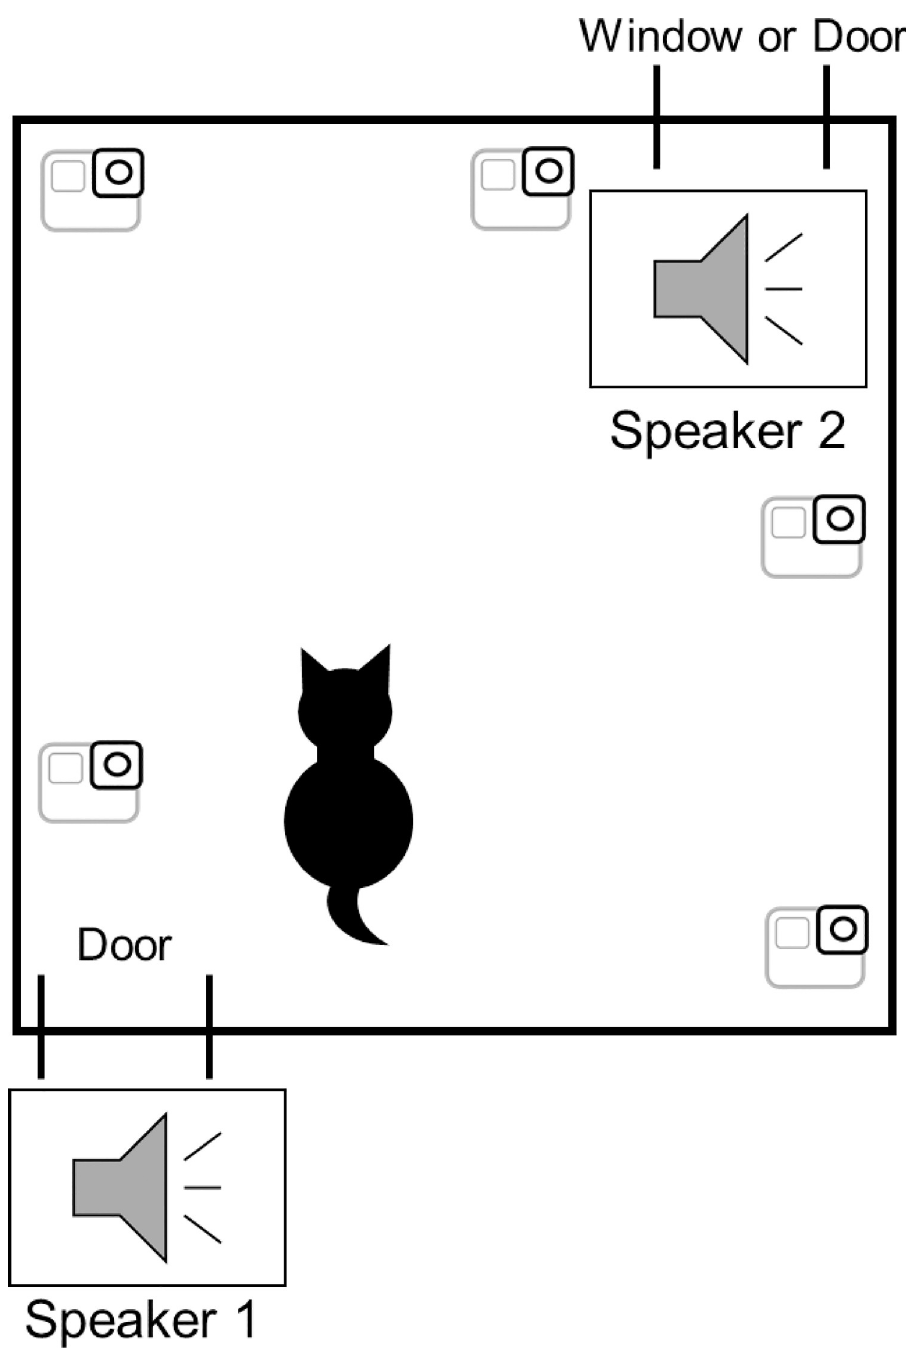
Fig 1. Arrangement of a testing room. There were slight differences across testing rooms depending on cats’ familiar spaces (house or cat cafe´). The Experimenter placed speaker 1 outside the test room and speaker 2 inside the test room close to another door or window leading to another room or outside. Cats were left alone and could move freely. Cat behaviors were recorded by video cameras during